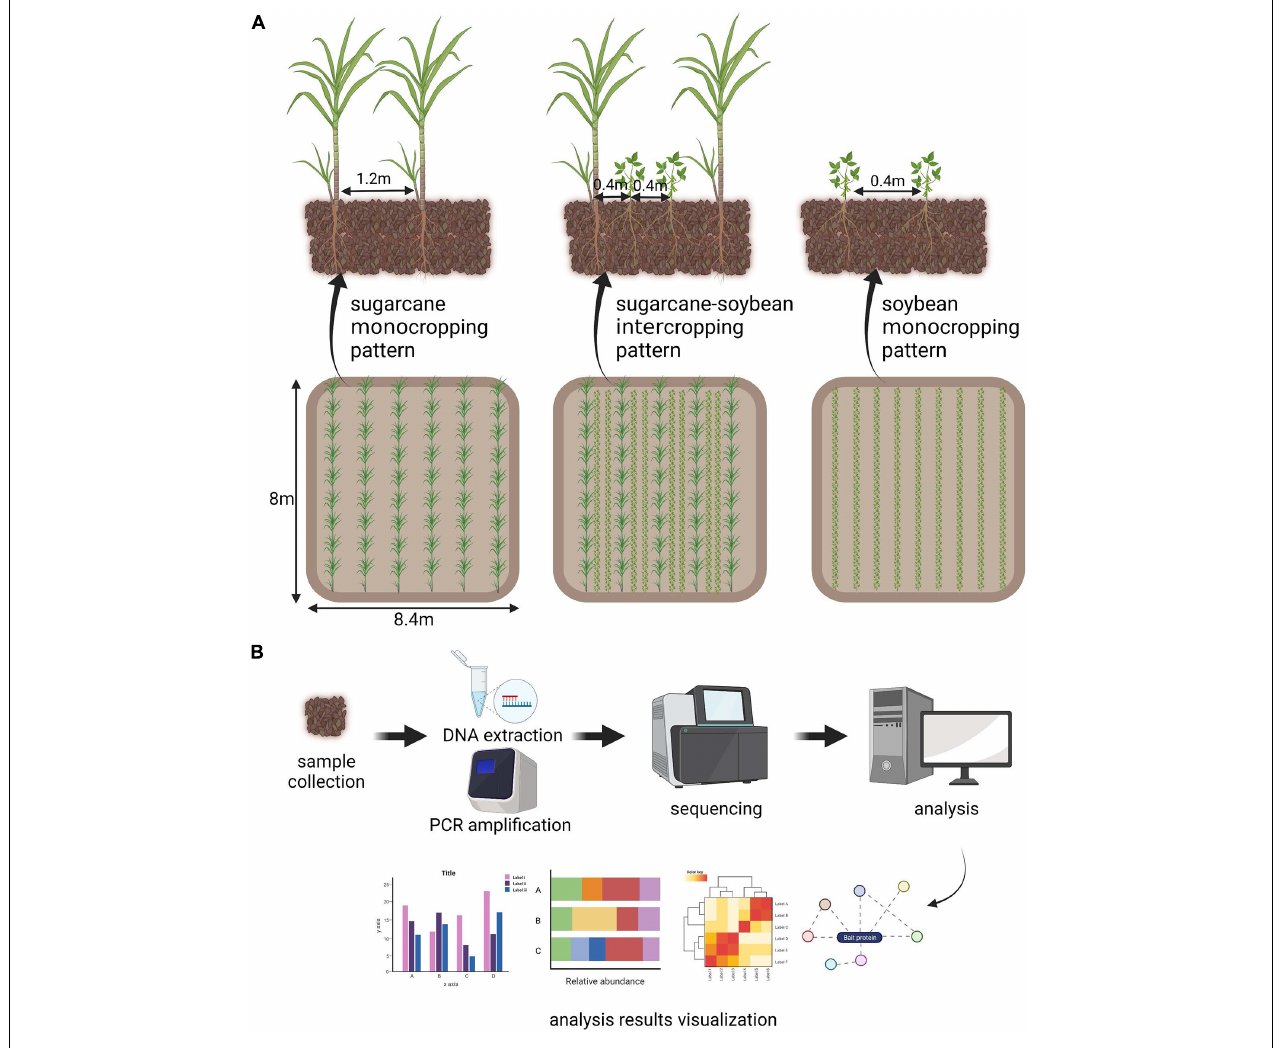
FIGURE 1 | (A) Self-interpretation diagram of experimental design. (B) Simple explanation of metagenomic analysis